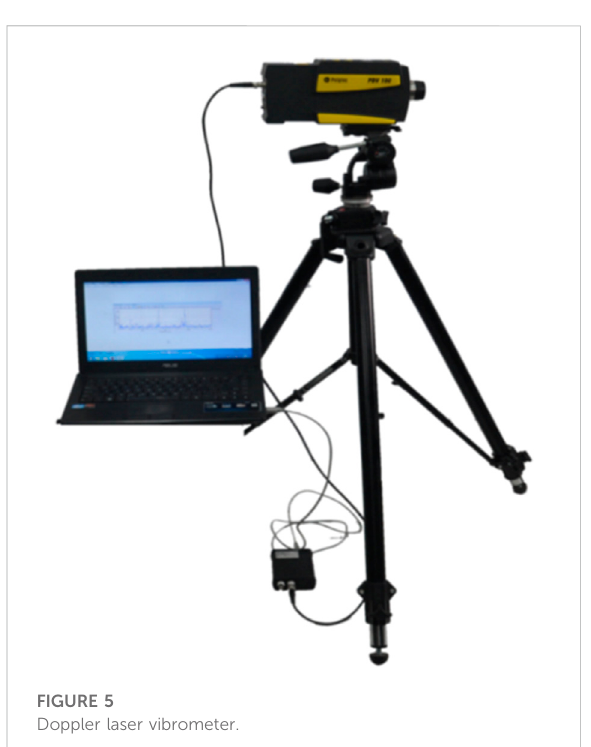
FIGURE 5 Doppler laser